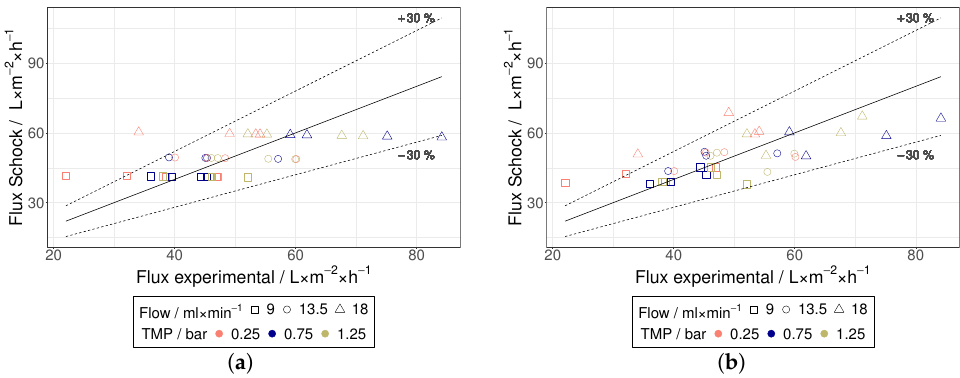
Figure 10. Experimental flux versus calculated flux according to Schock [24]; as function over u ( a ) for entire series of tests (1CS) and ( b ) for each MWCO (4CS). The straight line means a deviation of experimental versus model values by 0%, while the dotted lines show a deviation of ±